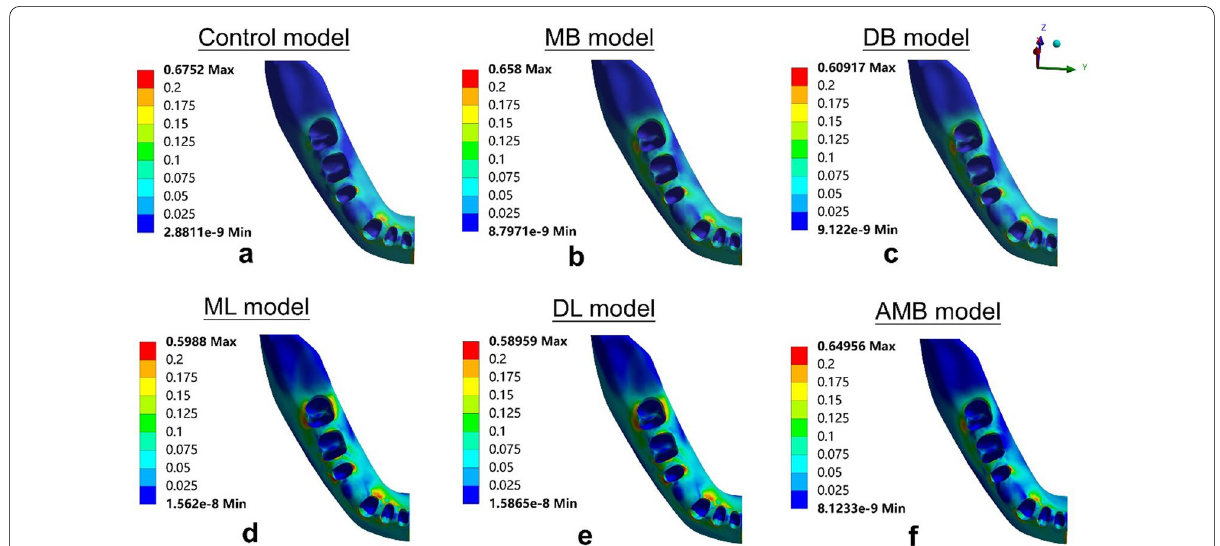
Fig. 10 von Mises stress distribution of alveolar bone in six models (occlusal view): a the control model, b the MB model, c the DB model, d the ML model, e the DL model, and f the AMB